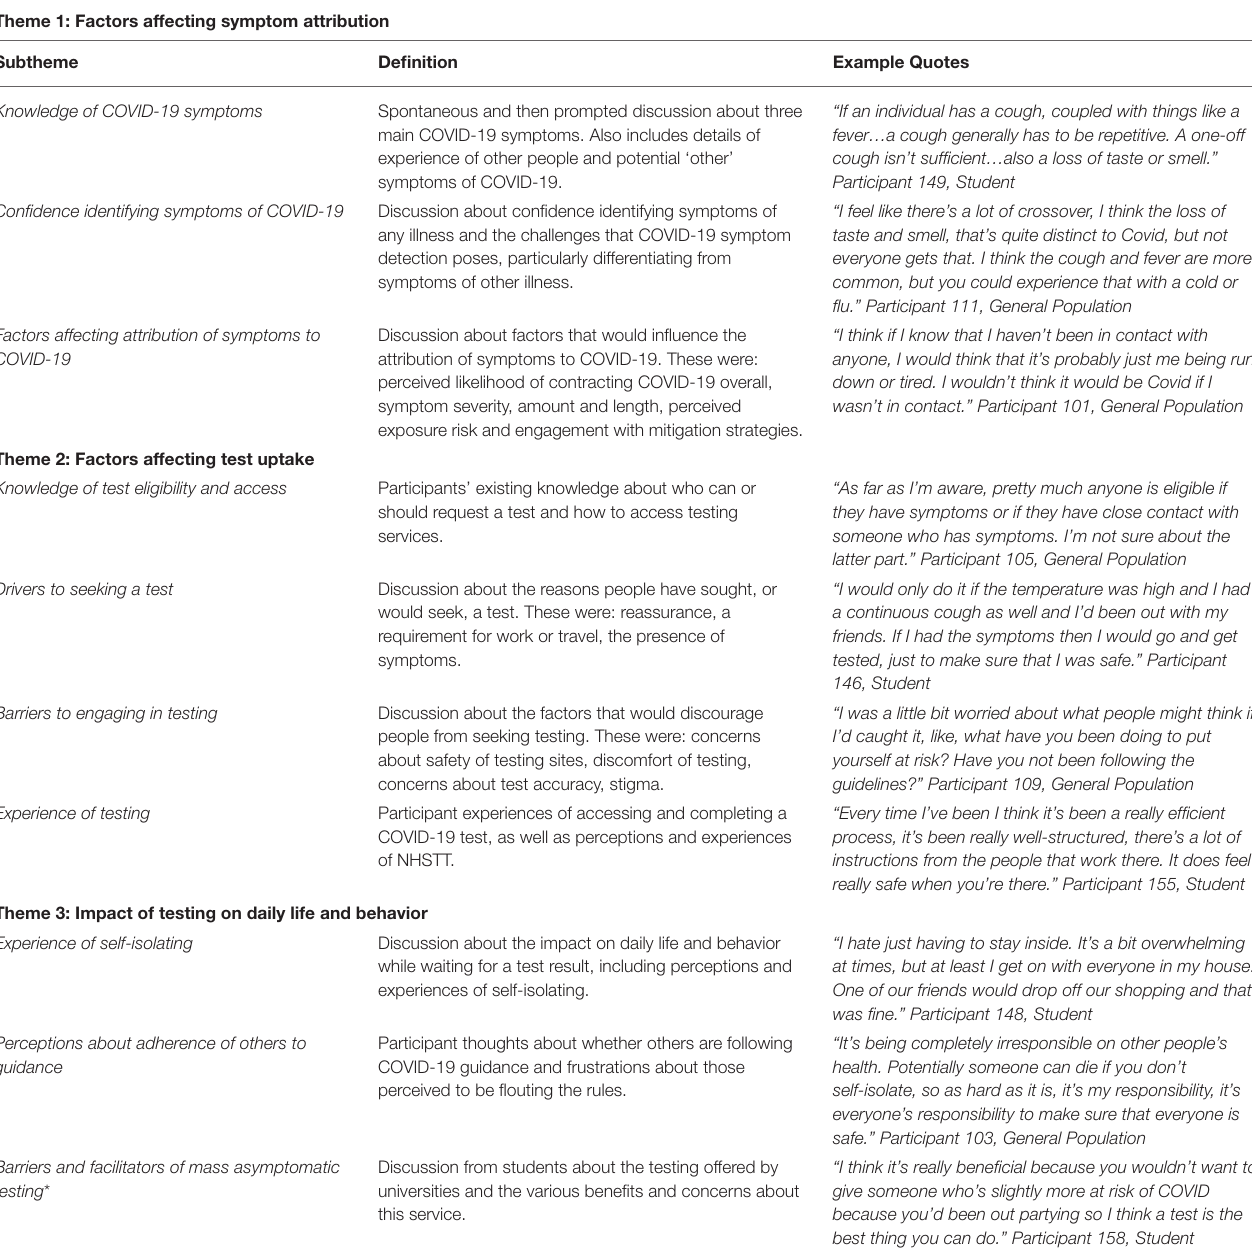
TABLE 2 | Analytical framework for developing themes for participant perceptions and experiences of COVID-19 symptoms and